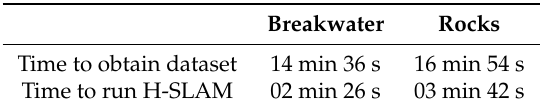
Table 2. Computing time comparison with dataset collection